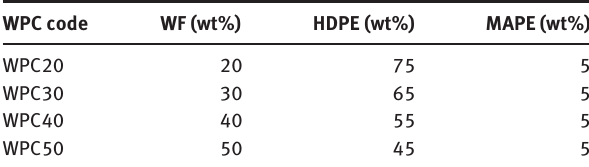
Table 3 WPC formulation and codes.